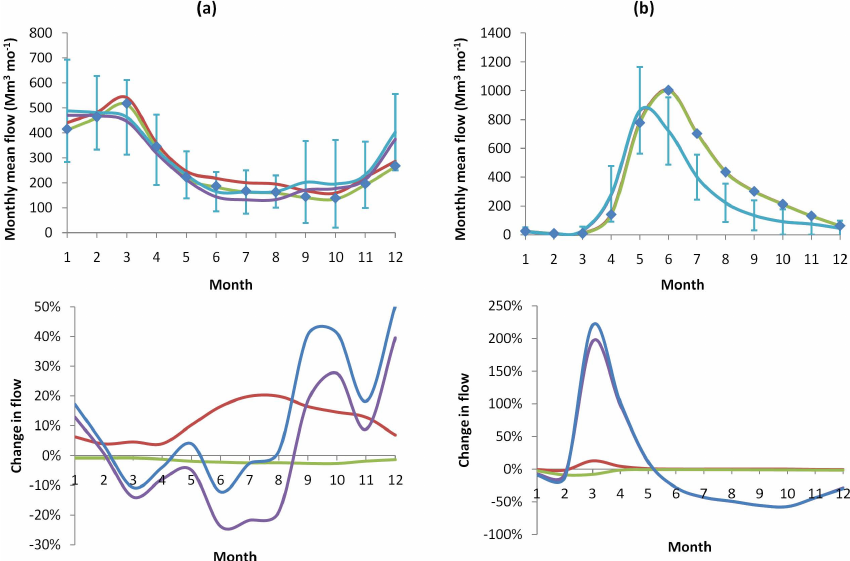
Fig. 8. Impacts of changes in impervious cover, withdrawals, and climate on monthly mean flows from 2010 levels by 2060 under the High growth and emission scenario for HUC watershed 03130001 – Upper Chattahoochee (Atlanta, GA area) (a) , and HUC watershed 14010001 – Colorado Headwaters (Denver, CO area by interbasin transfer) (b) . Error bars represent one standard deviation about the mean monthly flows when climate, impervious cover, and withdrawal impacts were